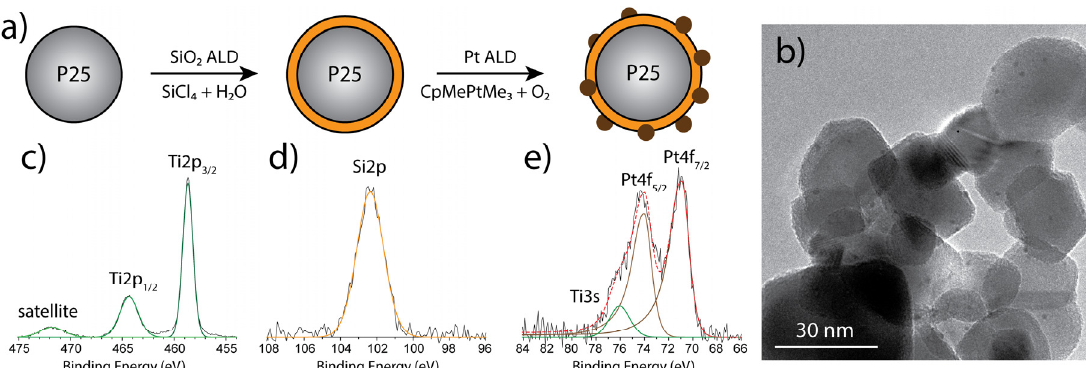
Figure 2. ( a ) Deposition scheme for the material development of Pt:SiO 2 :TiO 2 (P25), ( b ) TEM picture of Pt:SiO 2 :TiO 2 (P25) (1 wt. % Si, 1.23 wt. % Pt), grey large particle are P25 particles, SiO 2 layer around P25 particles can be observed, dark spots indicate Pt nanoclusters, ( c ) Ti 2p HRXPS spectrum with typical TiO 2 features, ( d ) Si 2p HRXPS spectrum, single peak represents SiO 2 (orange), ( e ) Pt 4f HRXPS spectrum, doublet peak represents Pt metal (brown), single peak represents Ti 3s satellite peak (green).